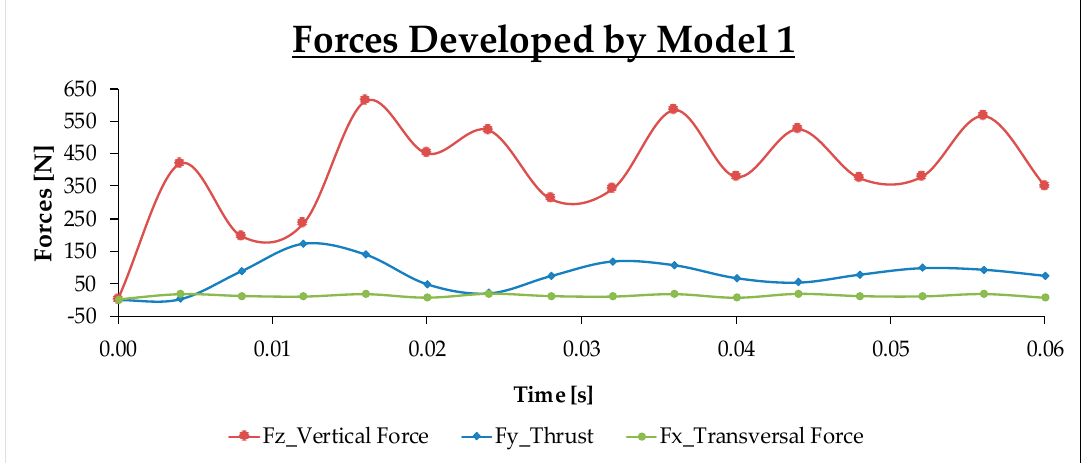
Figure 11. Forces in model 1.